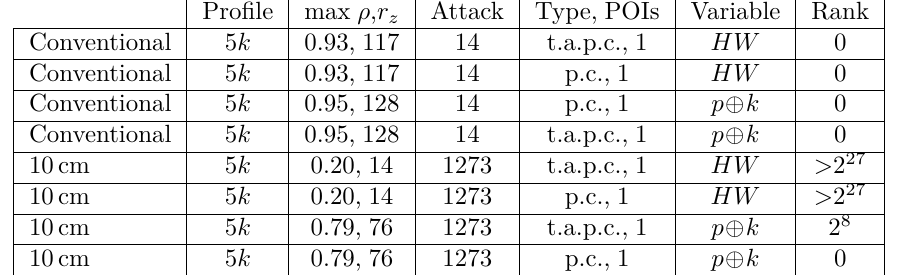
Figure 7: For the bits at the output of the Sbox, the linear model (red) is a good approxima- tion of the leak model (green) for the conventional case (a), but not for screaming channels (b). Table 2: Attack results confirm that choosing y = p ⊕ k is important to take into account the distortion present in screaming-channel leaks, whereas it does not make any significant difference in the conventional case. p.c. stands for profiled correlation, whereas t.a.p.c. stands for template attack with pooled covariance.